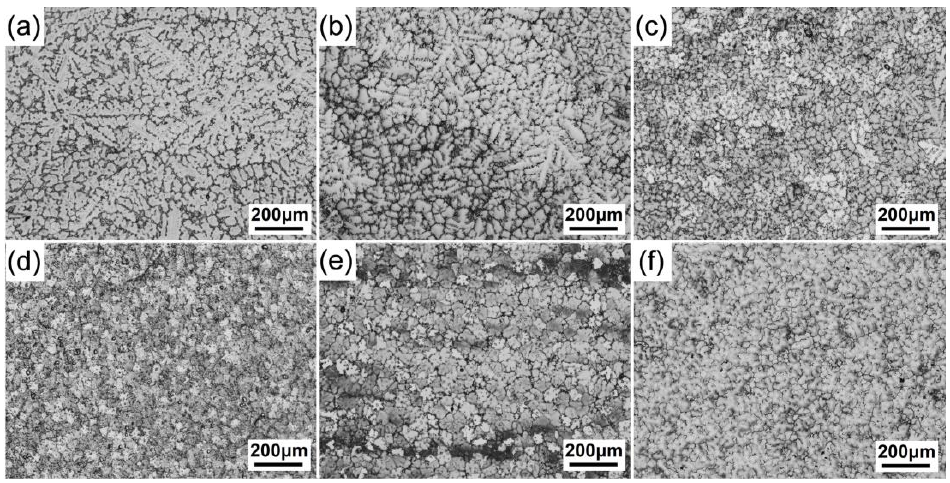
Figure 1. OM micrographs of the as-cast alloys: ( a – d ) 0.5Zn-xAl (x = 0, 0.2, 0.5, and 1.0); ( e ) 0Zn- 1.0Al and ( f ) 0.15Zr. and ( f )